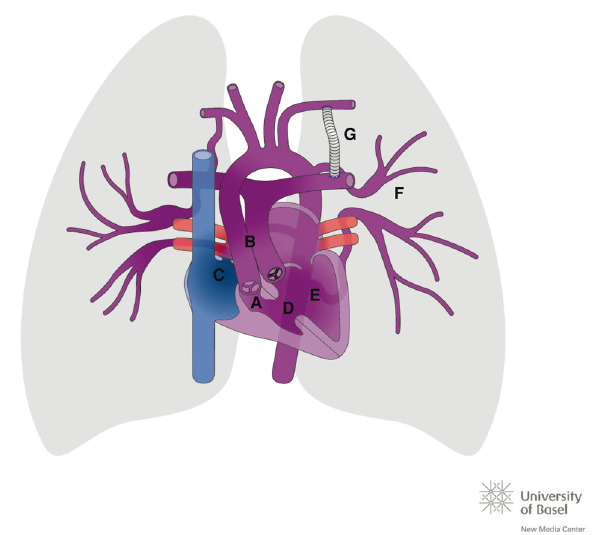
Figure 1. Schematic illustration of the patient’s cardiovascular anatomy showing (A) tricuspid atresia, (B) transposition of the great arteries, (C) atrial septum defect, (D) ventricular septum defect, (E) single-ventricle physiology, (F) major aorto-pulmonary collateral arteries, and (G) Blalock-Taussig shunt. Copyright © 2014 New Media Center, University of Basel. All Rights